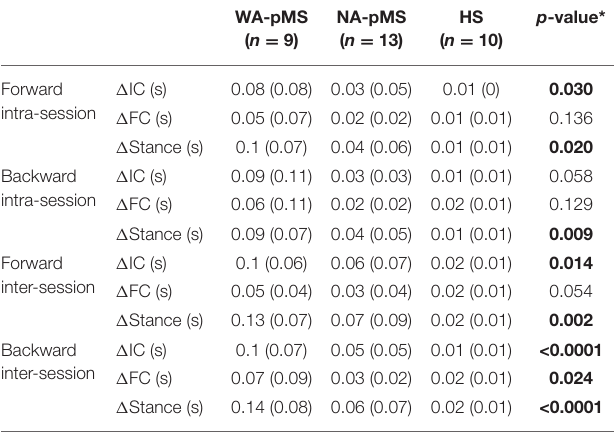
TABLE 6 | Accuracy ( 1 IC, 1 FC, and 1 Stance) scores for the IITD algorithm.